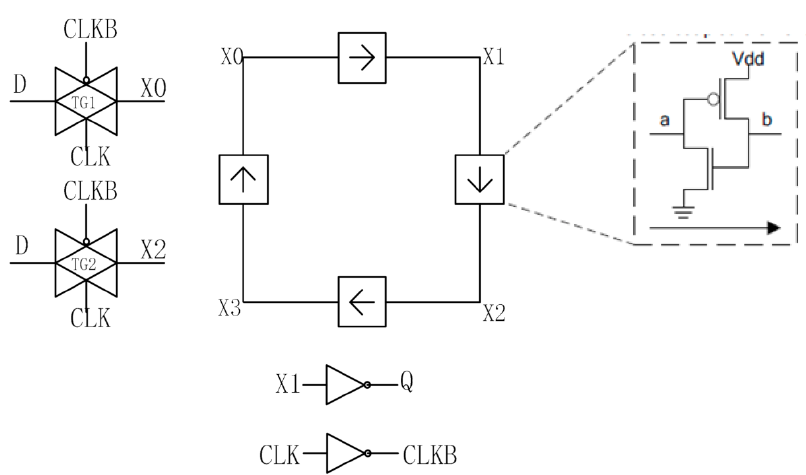
Figure 2. Simplified structure diagram of